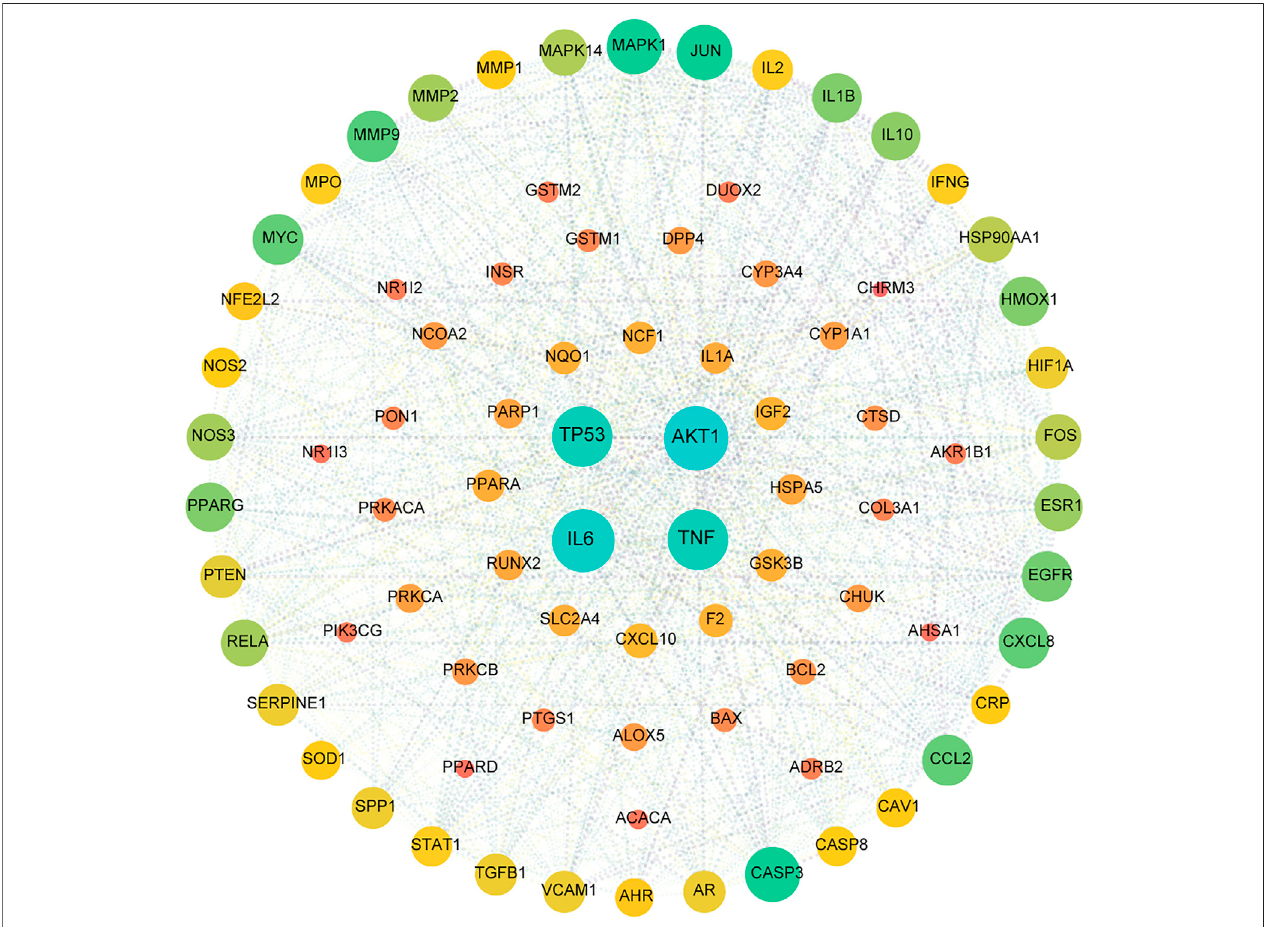
FIGURE 3 | PPI network for HX acting on NAFLD. This target network was composed of 82 nodes and 1,246 edges. A node represents one target, the degree value determines the node ’ s size, and the edges represent protein – protein relationships. The 82 nodes represent therapeutic targets for HX acting on NAFLD, and the lines denote the relationship of 1,246 targets. The nodes (TP53, AKT1, IL6, and TNF) have higher degrees.